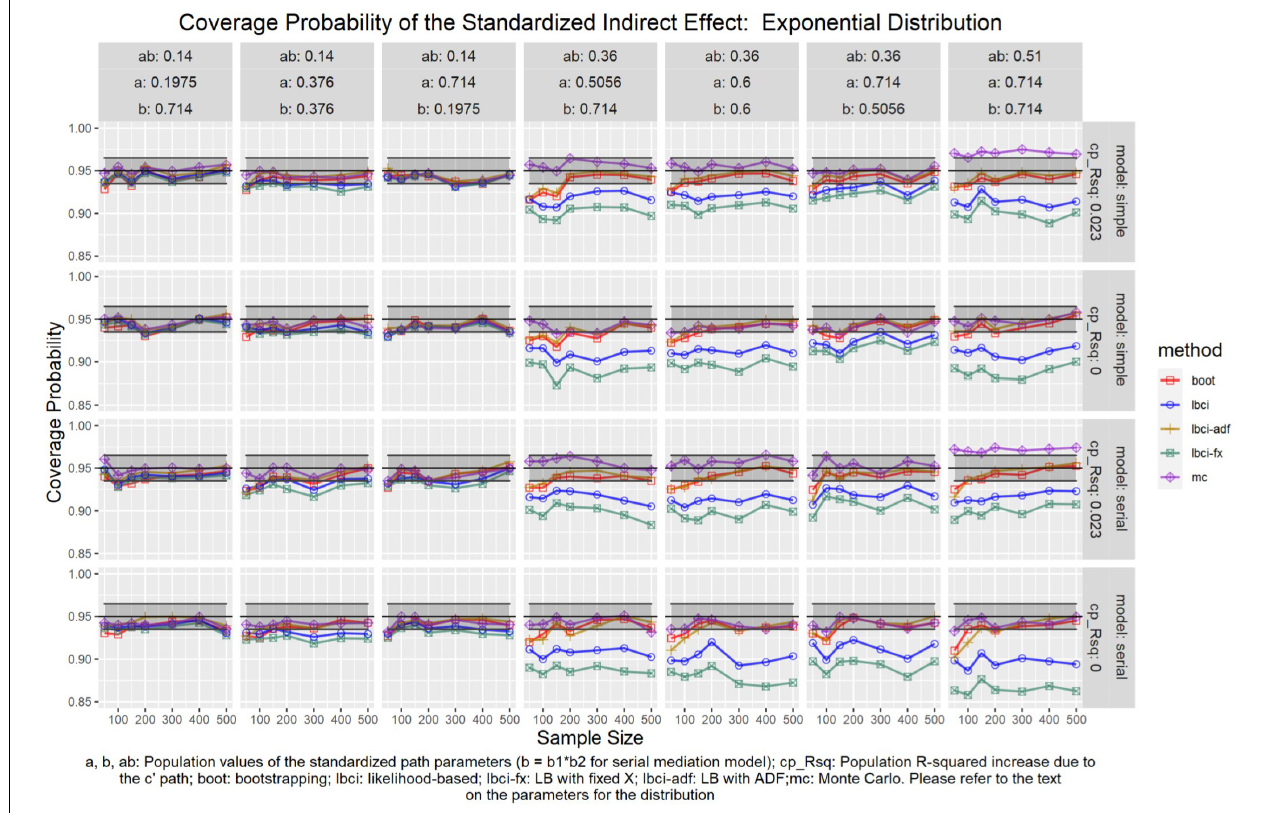
FIGURE 13 | Exponential Distribution (Standardized Indirect Effect). a, b, ab: Population values of the standardized path parameters (b = b1 × b2 for serial mediation model); cp_Rsq: Population R-squared increase due to the c (cid:48) path; boot: bootstrapping; Ibci: likelihood-based; Ibci-fx: LB with fixed X; Ibci-adf: LB with ADF;mc: Monte Carlo. Please refer to the text on the parameters for the